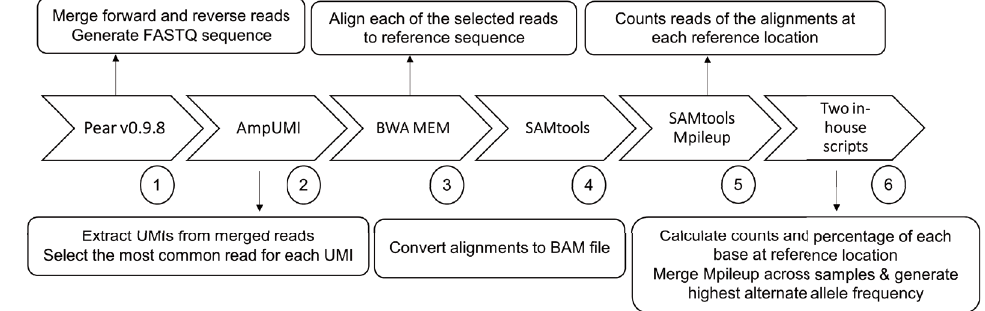
Figure 4. ( A ) Workflow illustrating UMI based methods for amplifying individual strands of genomic DNA within pooled samples of hookworm eggs. ( B ) Workflow illustrating in silico analysis of next generation sequencing data representing pre- and post-treatment hookworm egg